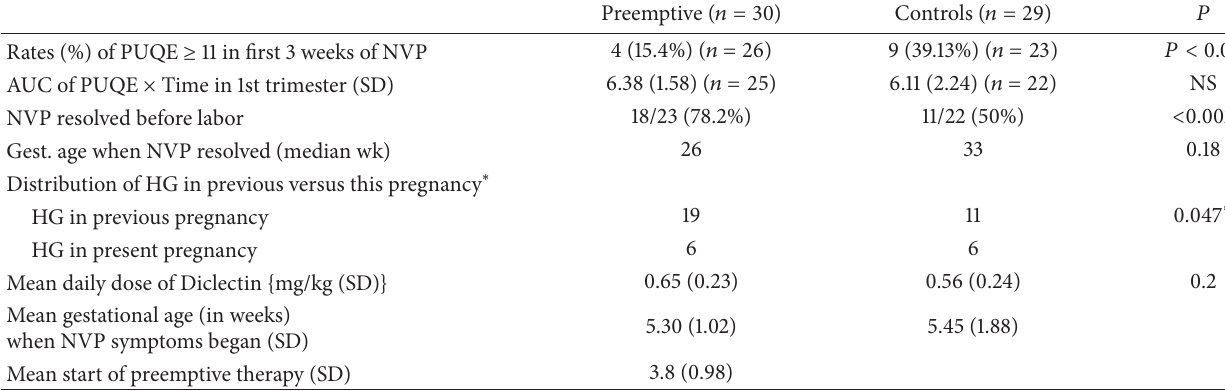
Table 4: Comparison of effectiveness between the two